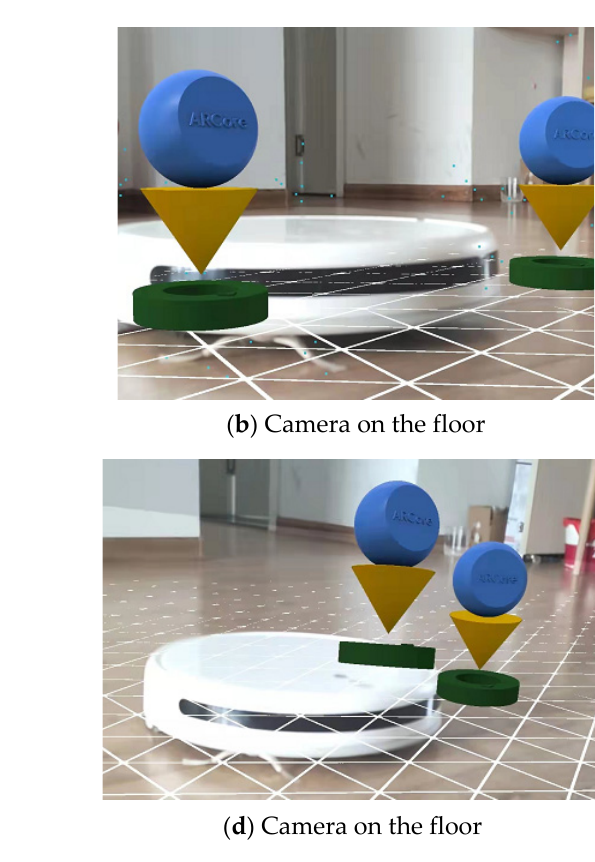
Figure 10. image ( a , b ) are results of ARCore without the proposed method; image ( c , d ) are results ARCore with the proposed of ARCore with the proposed method.